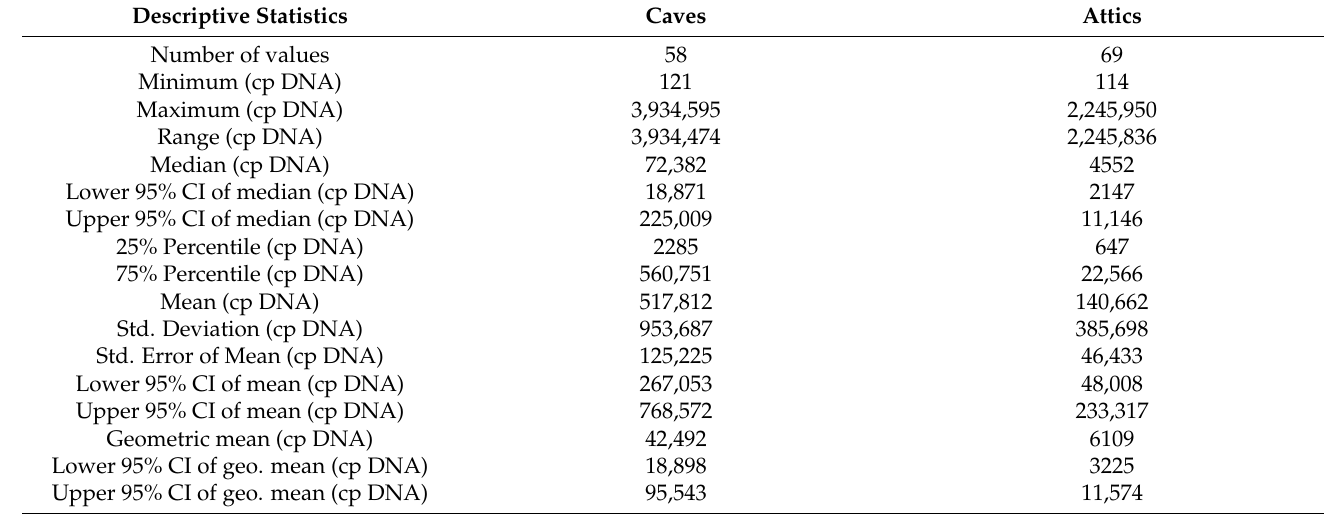
Table interpretation. qPCR = quantitative PCR test; cp DNA = copies of DNA; CI = Confidence